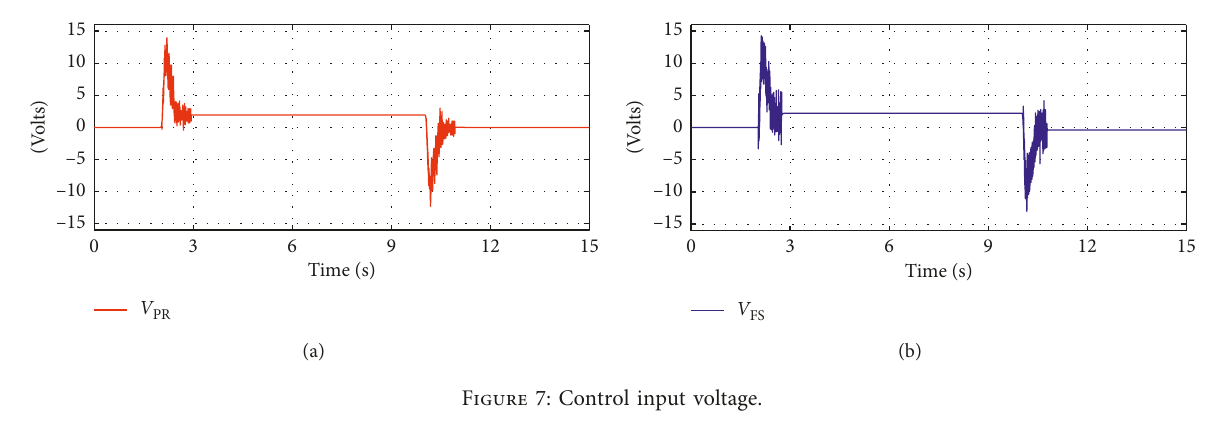
Figure 6: Tracking error.